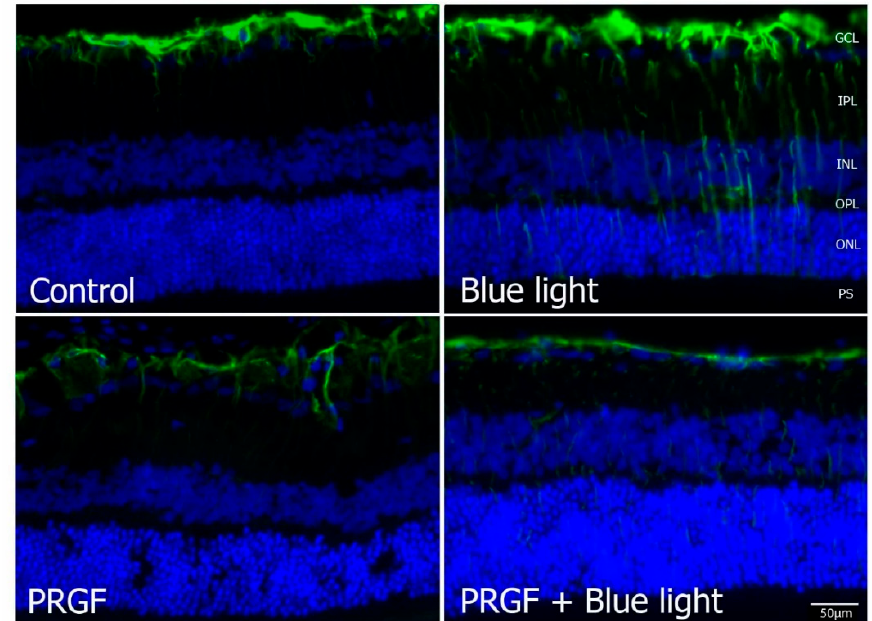
Figure 8. Immunofluorescence for GFAP (green) and DAPI (blue) in transversal section of retinas ( n = 4). The results showed that blue light increased its expression compared to control. However, PRGF combined with blue light reduced the expression, even more than that in the control results. Scale = 50 µ